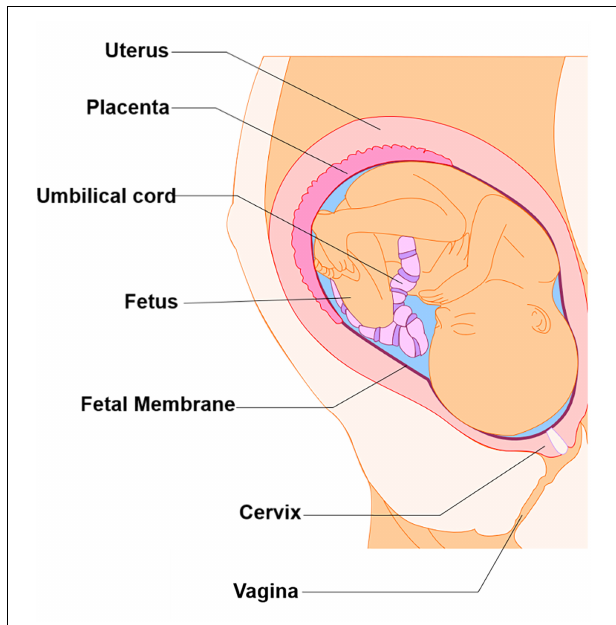
FIGURE 1 | Intra-uterine tissue anatomy. An illustration of the anatomy of the intra-uterine tissue broken down into maternal and fetal components. Maternal tissues comprise of the uterus (i.e., Myometrium), cervix, and vagina, while the fetal tissues include the placenta, umbilical cord, fetus, and fetal